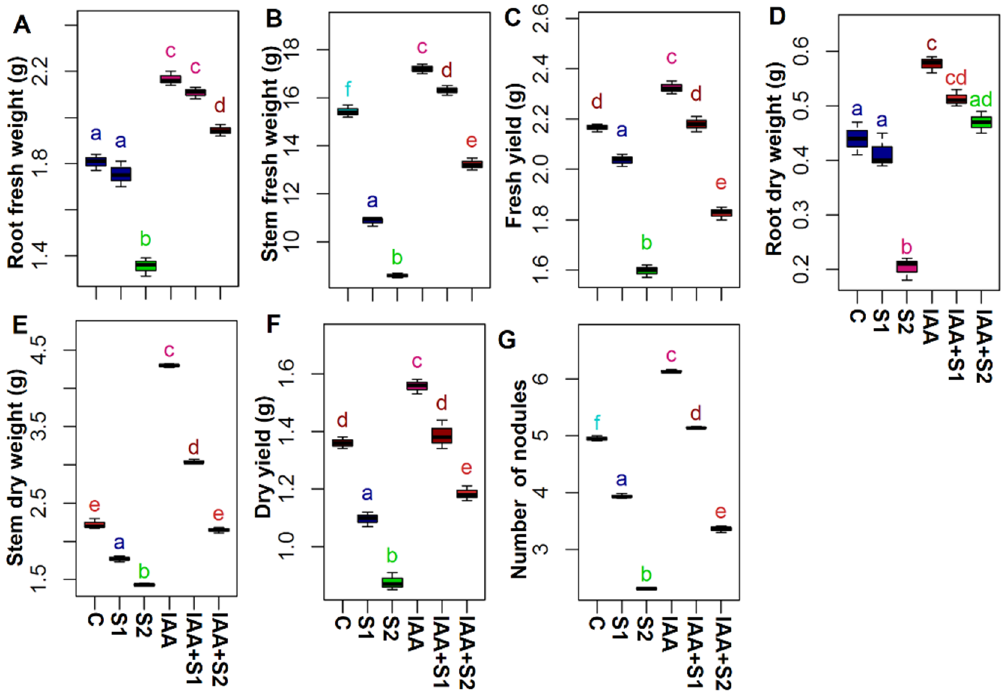
Figure 1. Effects of exogenous indole-3-acetic acid (IAA) on various growth traits, such as ( A ) root fresh weight, ( B ) stem fresh weight, ( C ) fresh yield, ( D ) root dry weight, ( E ) stem dry weight, ( F ) dry weight, ( G ) number of nodules, of V. faba plants grown under non-stress and saline conditions. Each boxplot represents values of three independent replicates ( n = 3). Different letters above the bars indicate a statistically significant difference ( p < 0.05) by Tukey’s test. C, (control) 0 mM NaCl + water spray; S1, 60 mM NaCl + water spray; S2, 150 mM NaCl + water spray; IAA, 0 mM NaCl + 200 ppm IAA; IAA + S1, 60 mM NaCl + 200 ppm IAA; IAA + S2, 150 mM NaCl + 200 ppm IAA.